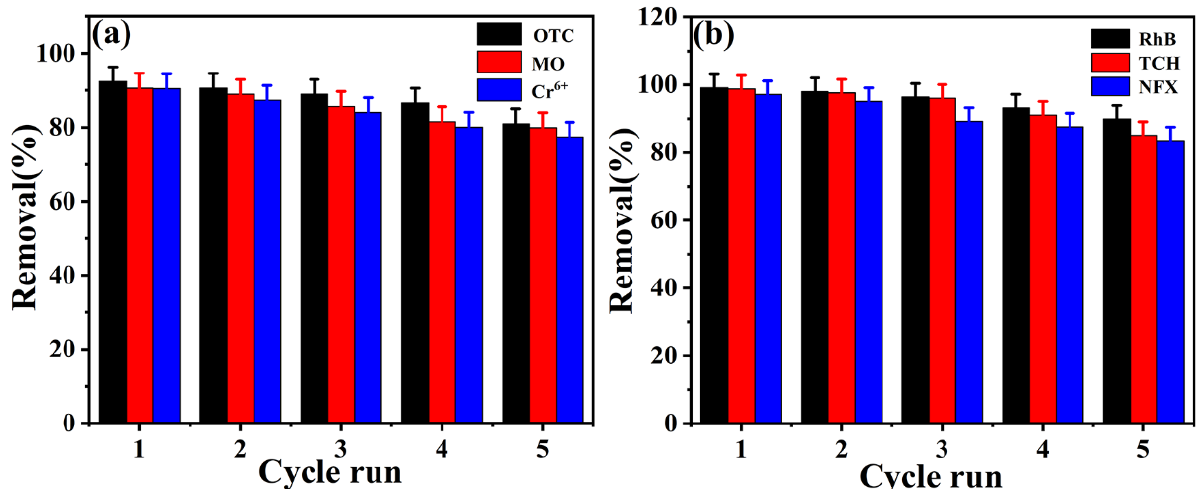
Figure 8. Cyclic experimental degradation diagram of CFO/C-PNS photodegradation of ( a ) OTC, MO and Cr(VI), and ( b ) RhB, TCH and